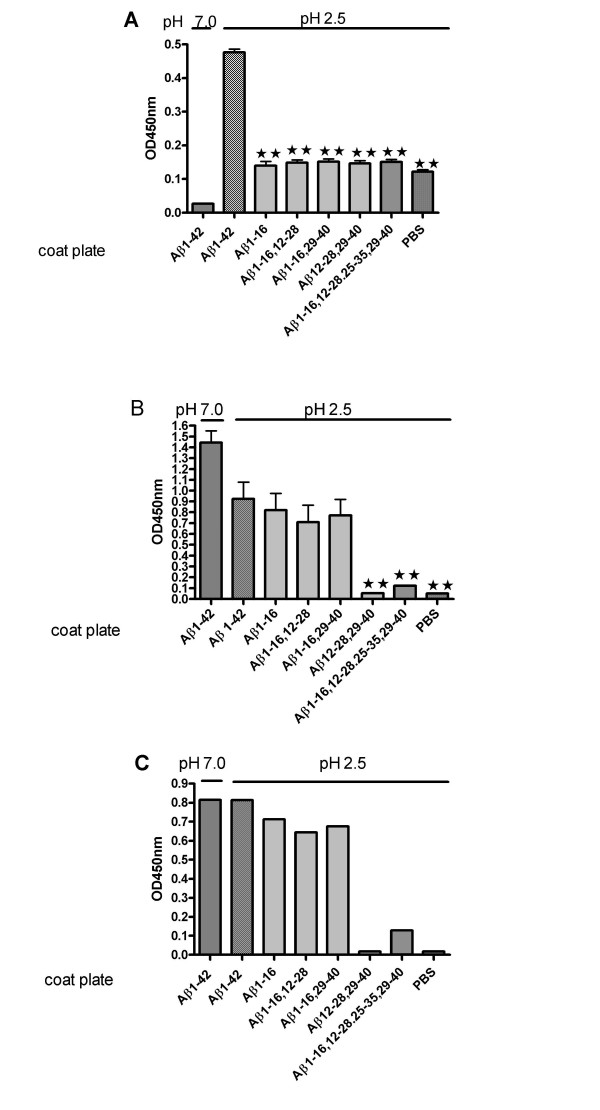
Incubation at pH 2.5 induced artifactual ELISA signal only interacts with full length Aβ; Authentic antibodies bind both full length Aβ and N terminal fragments. Epitope mapping of normal sera from unvaccinated mice (panel A;1:400 dilution), mice vaccinated with Aβ1–42 peptide (panel B; 1:400 dilution) or mouse anti-human Aβ1–16 monoclonal antibody (6E10; 4C;50 ng/ml) was performed. Full length human Aβ and human Aβ fragments (singly and in combination as indicated on graph) were used to coat the plate and identify the domain that interacted with the IgG fractions following pH 7 preincubation (full length Aβ only) or incubation at pH 2.5 for 20 minutes at RT. After centrifugation and neutralization the samples were then incubated on ELISA plates coated as indicated. Values are mean ± SEM. ** P < 0.001 compared to pH 2.5 plate coated with Aβ1–42 peptide.